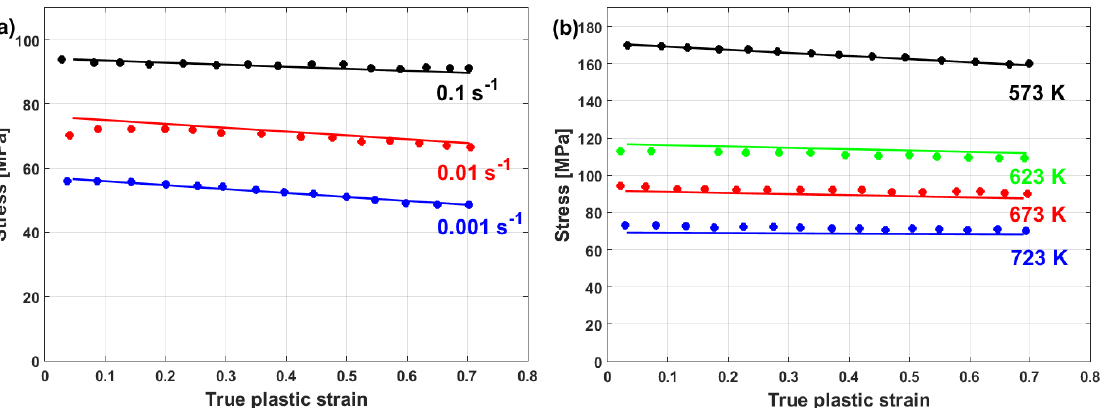
Figure 24. Comparison of experimental stresses (markers) and predicted stresses (solid lines) using the modified JC model that was presented by Lin et al. [79] for 7075 Al alloy at ( a ) 673 K and ( b ) 723 K.